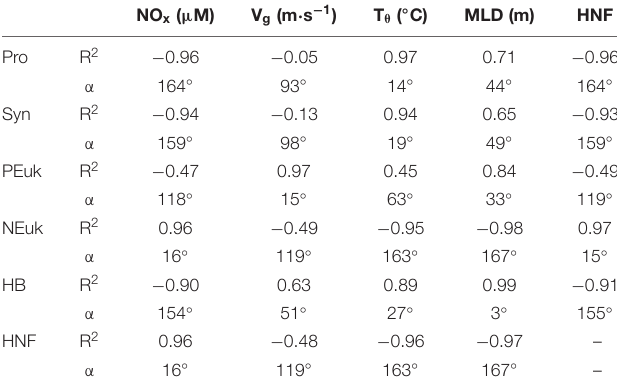
TABLE 3 | Correlation coefficients (R 2 ) and angles ( α ) between phytoplankton groups – Prochlorococcus (Pro), Synechococcus (Syn), picoeukaryotes